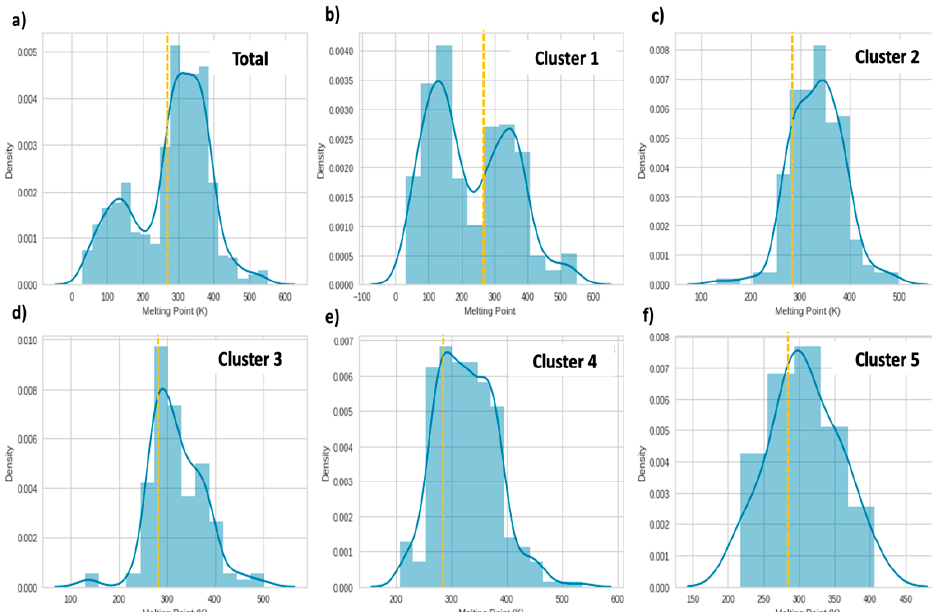
Figure 4. The distribution of melting points based on the ( a ) total 1253 ILs dataset, ( b – f ) cluster/group 1–5 ILs dataset that found from k-means clustering analysis. The orange dotted line highlights a boundary with T = 273 K that distinguish the low melting ( T m < 273 K) and high melting point ( T m > 273 K) ILs system. The median T m from distribution of ( a – f ) is 279 K, 228 K, 322 K, 333 K, 317 K, 328 K.